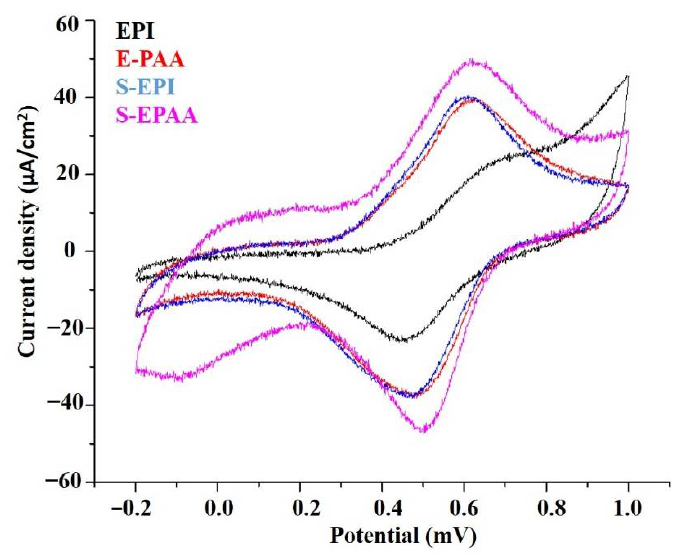
Figure 2. Electrochemical cyclic voltammetry for the as-measured samples in 1.0 M H 2 SO 4 at a scan rate of 50 mV/s, with a potential range of −0.2 V~1.0 V.